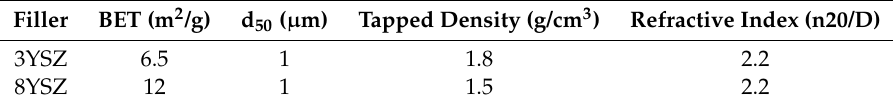
Table 2. Characteristics of the synthesized zirconia powders.